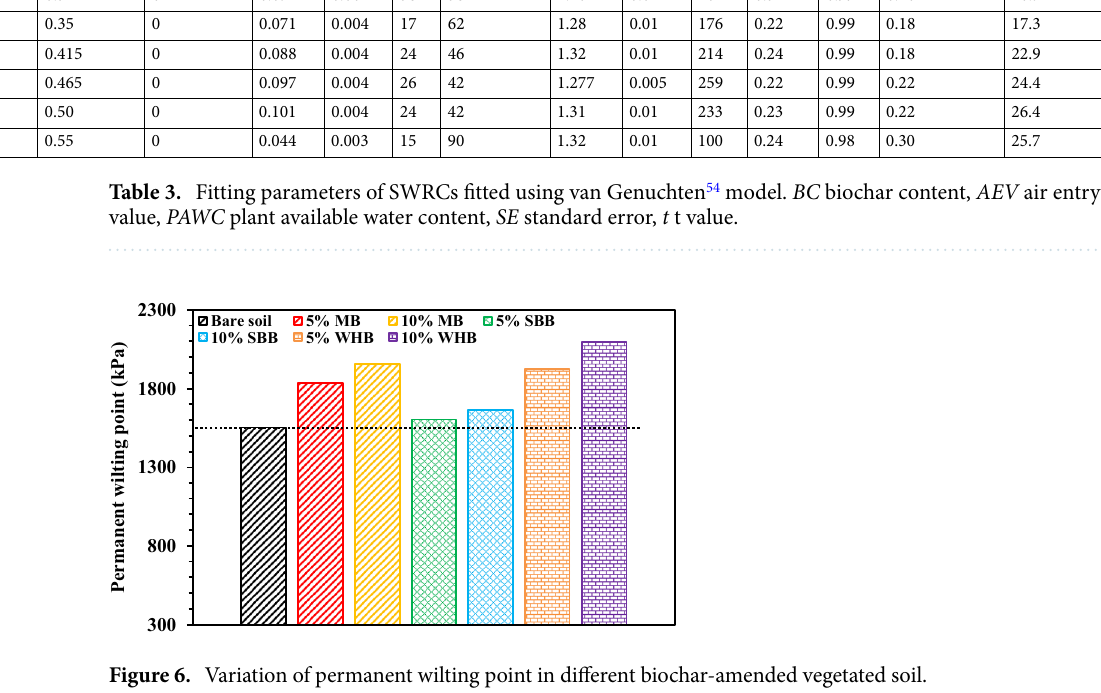
Figure 6. Variation of permanent wilting point in different biochar-amended vegetated